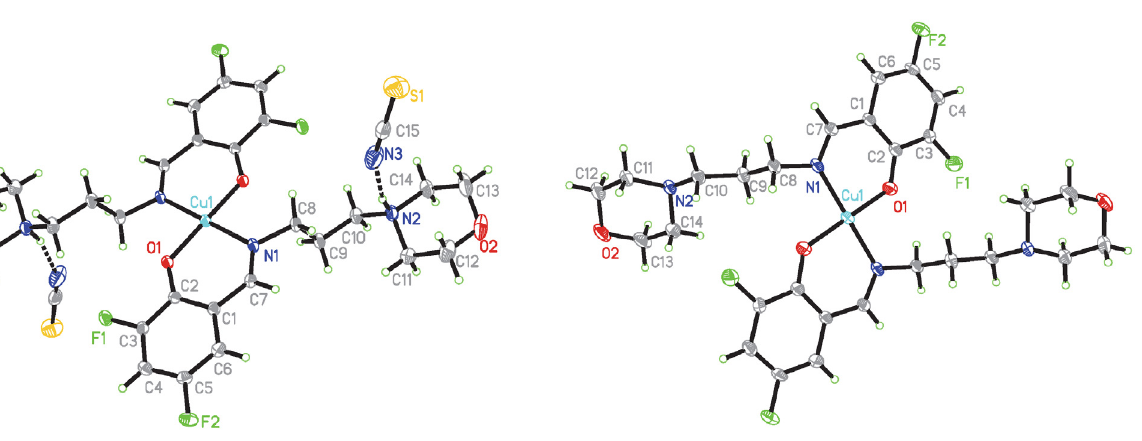
Figure 5. A perspective view of complex 3 with the atom labeling scheme. Thermal ellipsoids are drawn at the 30% probability level. Hydrogen bonds are shown as dashed lines.